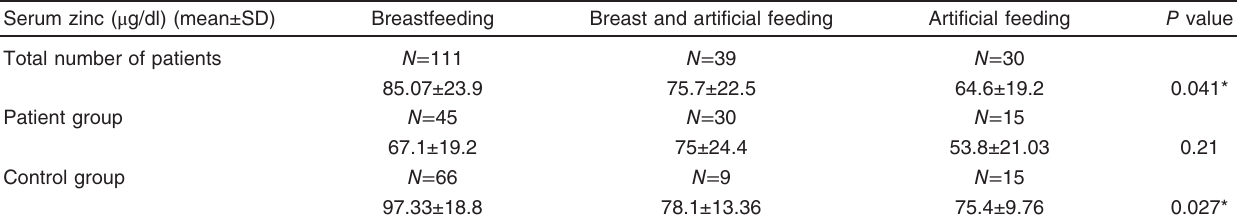
Table 5 Comparison of serum zinc level according to feeding type among patients and controls ( N = 60) Serum zinc ( μ g/dl) (mean±SD)